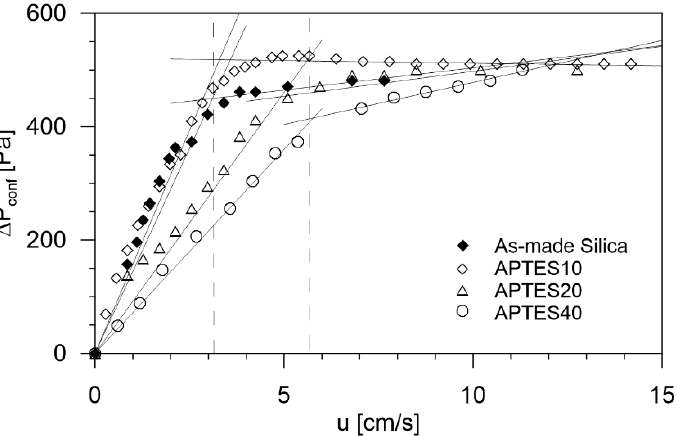
Figure 7. Diagram of confined fluidization tests on all samples investigated: data of as-made silica, APTES20, and APTES40 from reference 35.